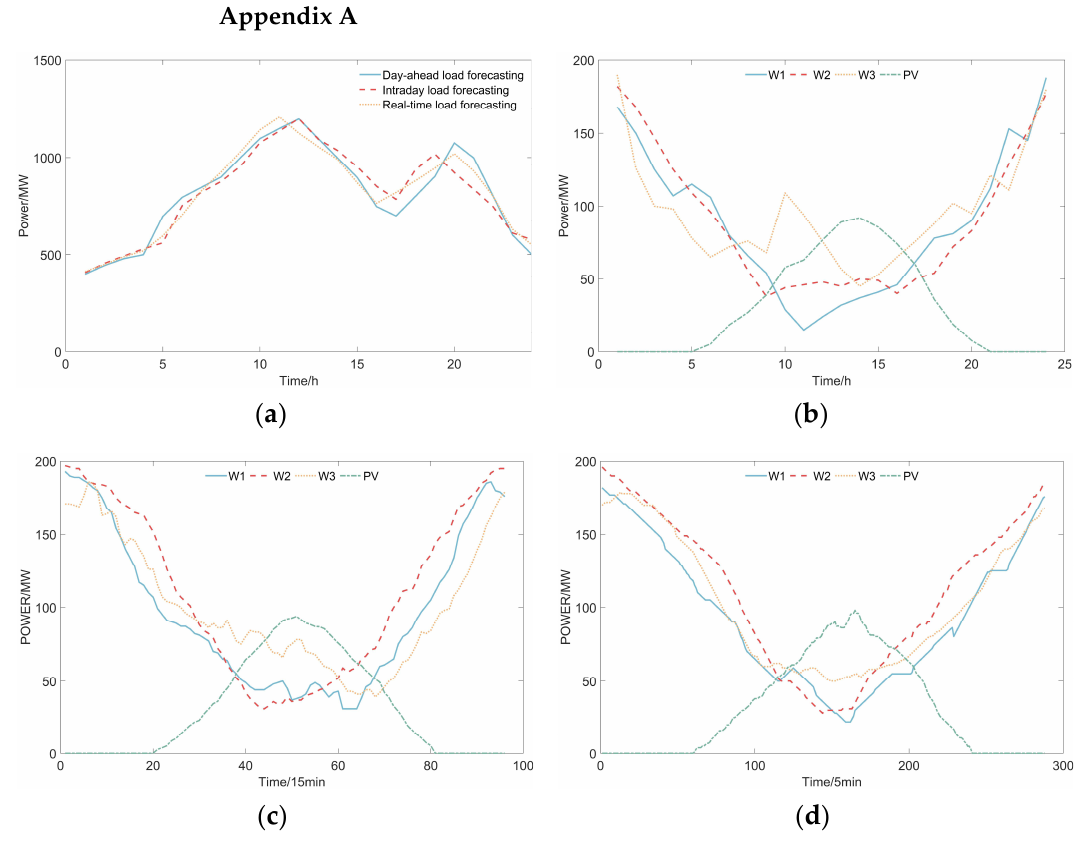
Figure A1. ( a ) Load prediction, ( b ) prediction of wind farms and photovoltaics in the day-ahead scheduling period, ( c ) prediction of wind farms and photovoltaics in the intraday scheduling period, and ( d ) prediction of wind farms and photovoltaics in the real-time scheduling period.